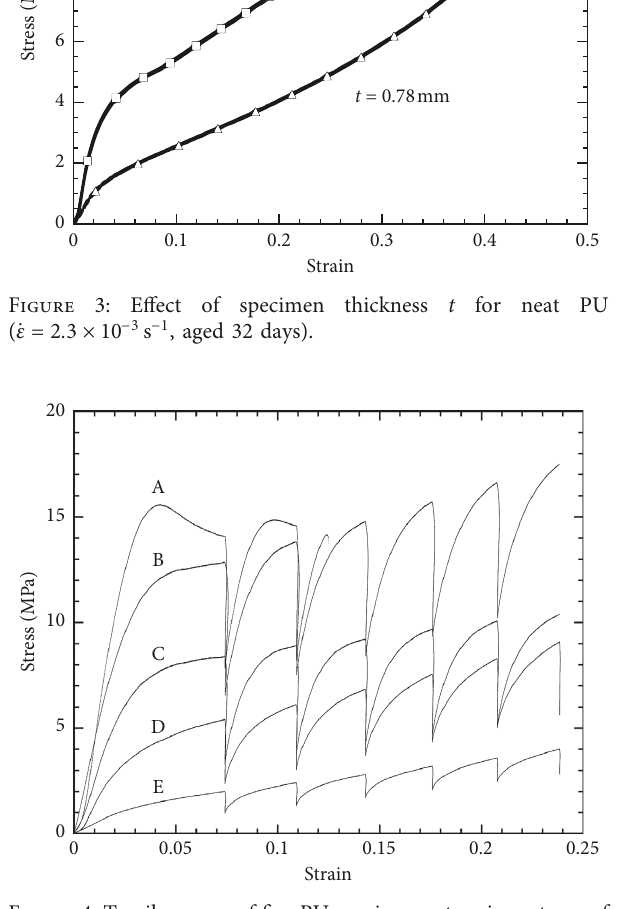
Figure 4: Tensile curves of five PU specimens at various stages of aging and with various thicknesses, interrupted by 30s stress re- laxation tests; _ ε 2 . 3 10 (cid:31) ×